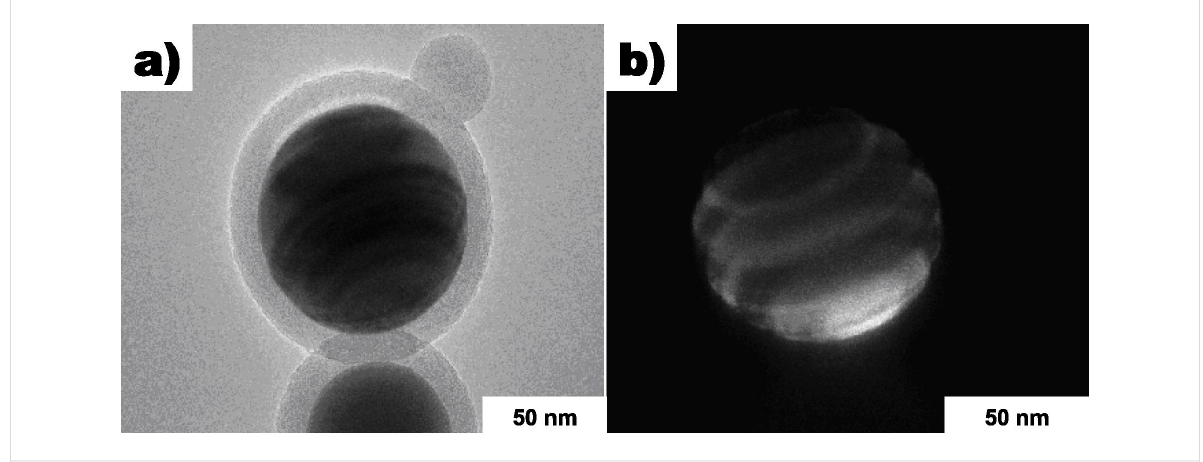
Figure 2: TEM micrograph of a Cu@silica nanoparticle. a) Bright field, b) dark field.